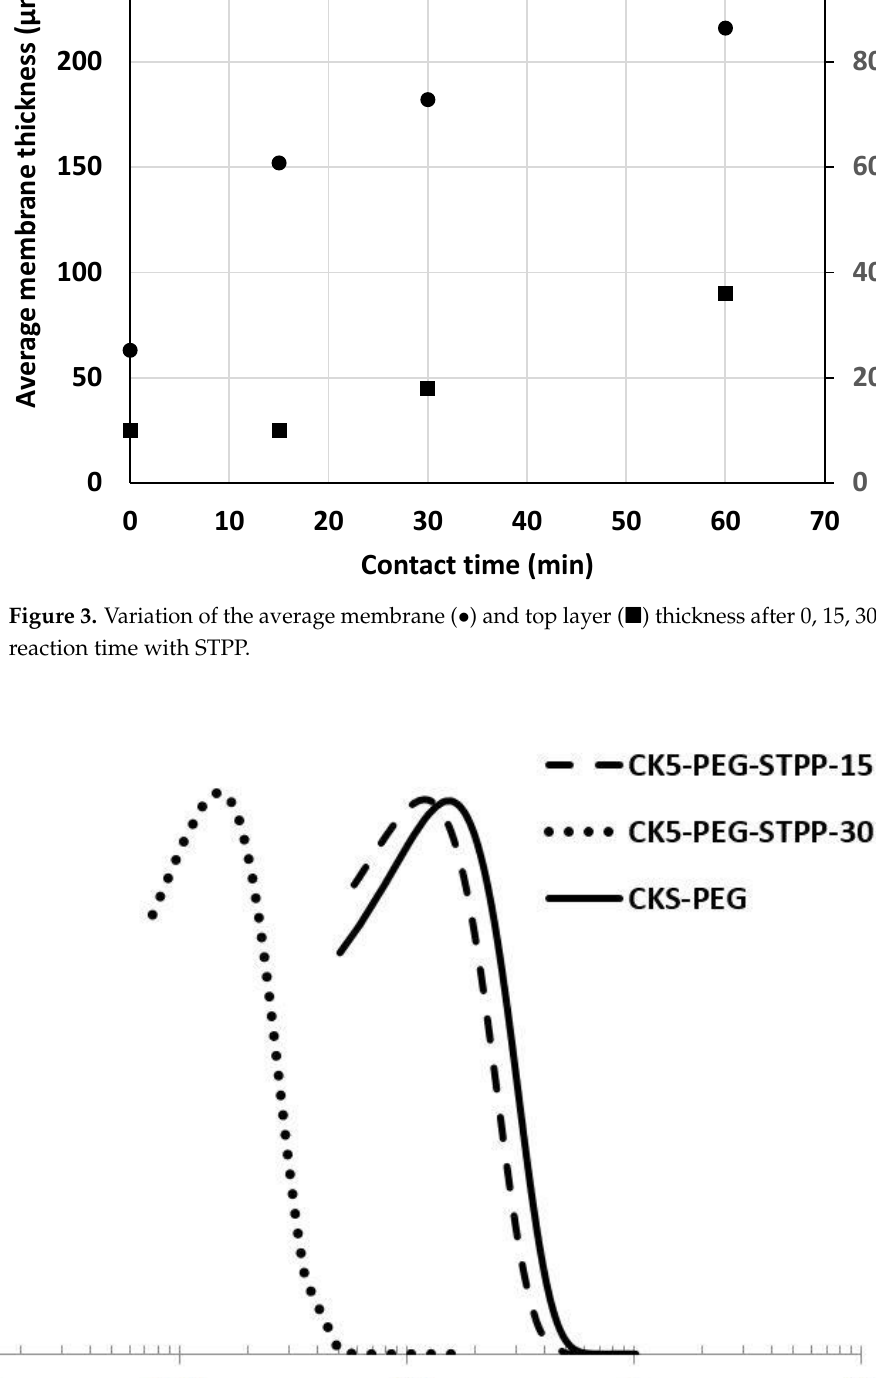
9 of 19 Figure 2. SEM pictures of the membrane surface after 0, 15, 30 and 60 min of reaction time with STPP (a),(c),(e),(g), respectively ( left , magnification x 50,000) and membrane cross-section ( right , magnification x 500 for (b),(d),(f )and X300 for (h)). Figure 2 (right) shows micrographs of the corresponding membrane cross-sections. SEM observation revealed that the introduction of PEG into the KO/CS suspension re- sulted in a highly porous sponge-like structure with interconnected pores on the surface and the appearance of finger-like structures underneath. As mentioned above, similar structures characteristic of the non-solvent phase inversion method have been found for other types of composite membranes [6], and the mechanism of their formation has been explained by different authors [18-19]. Cross-linking resulted in membrane thickening without affecting the finger-like structure significantly, except in the case of the longer reaction time (CK5-PEG-STPP60). The gradual penetration of STPP and intercalation be- tween CS chains through electrical interactions are assumed to lead to the expansion of the polymer network, resulting in thickening of the top layer and that of the membrane cross-section. Figure 3 shows the evolution of the average thickness of the composite membrane and that of the surface layer above the finger-like structure determined from the SEM images, as a function of contact time with the STPP solution. A two-step process could explain these findings: first, a rapid diffusion of STPP in-